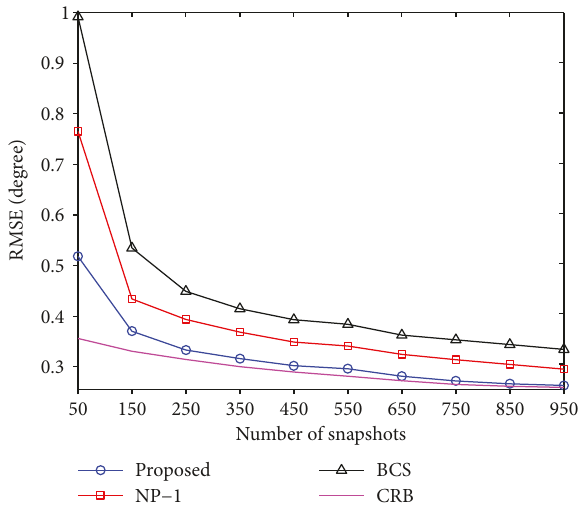
Figure 8: RMSE versus grid number with the fi xed SNR 10 dB and number of snapshots 500.